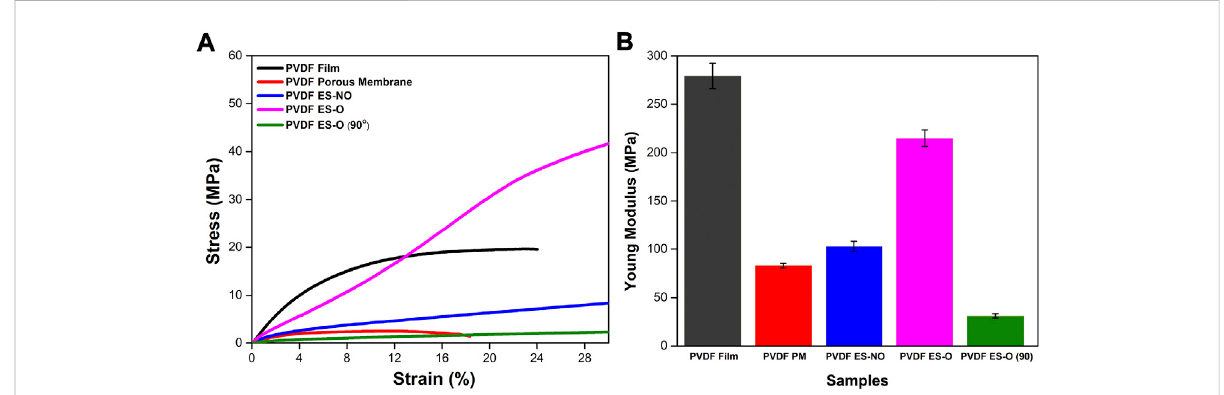
FIGURE 3 (A) Stress-strain curves up to 28% of strain for the PVDF fi lm, porous membrane (PM), electrospun randomly-oriented membranes (ES-NO), electrospun oriented membranes (ES-O) and 90 ° electrospun oriented membranes [ES-O (90 ° )]. (B) Young ’ s modulus with mean and standard